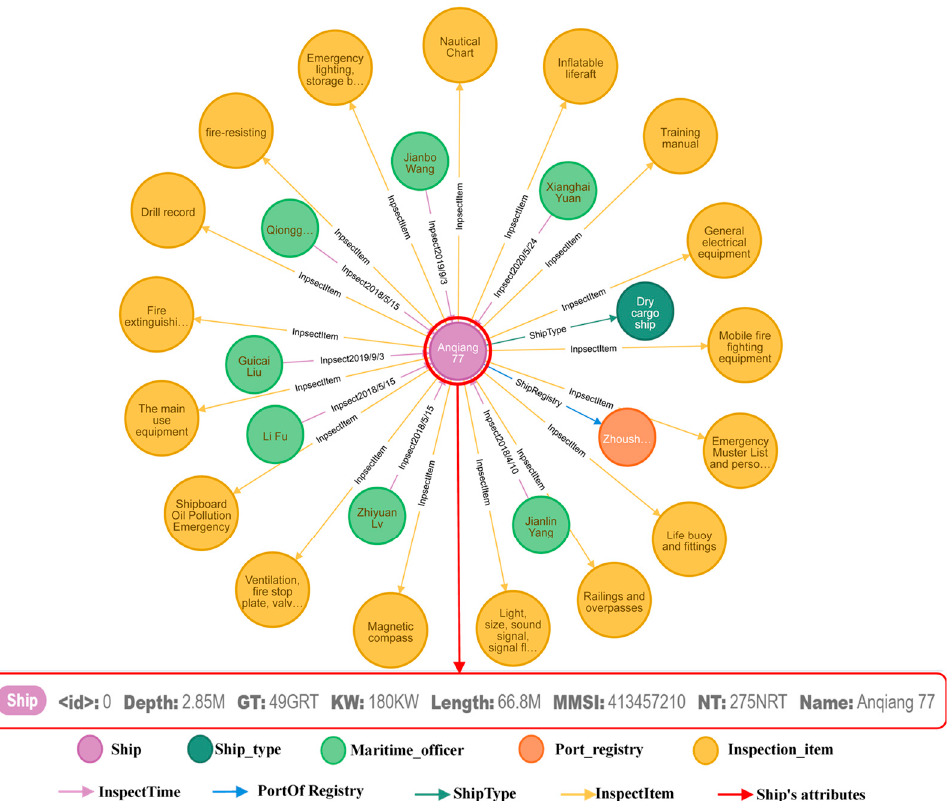
Figure 9. Ship association information retrieval for the ship “Anqiang77”.